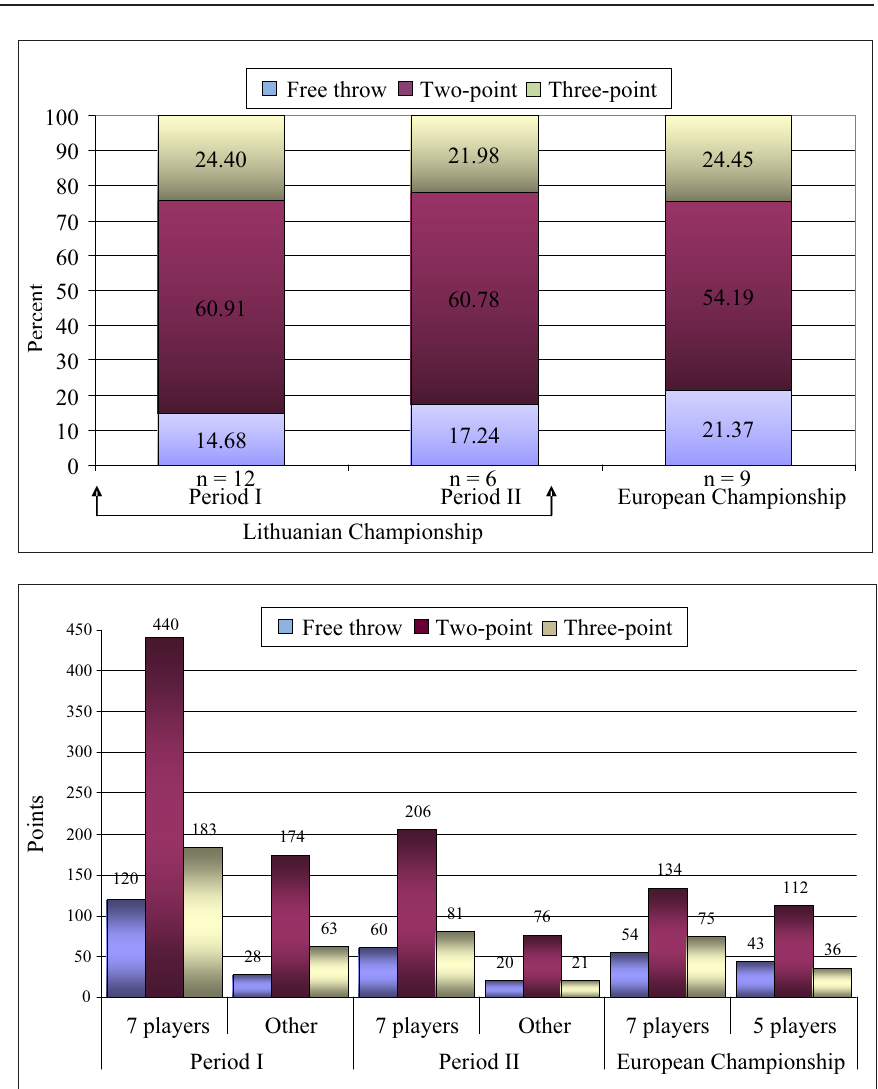
Figure 4. Contribution of LBC players at Lithuanian championship (period I and period II)